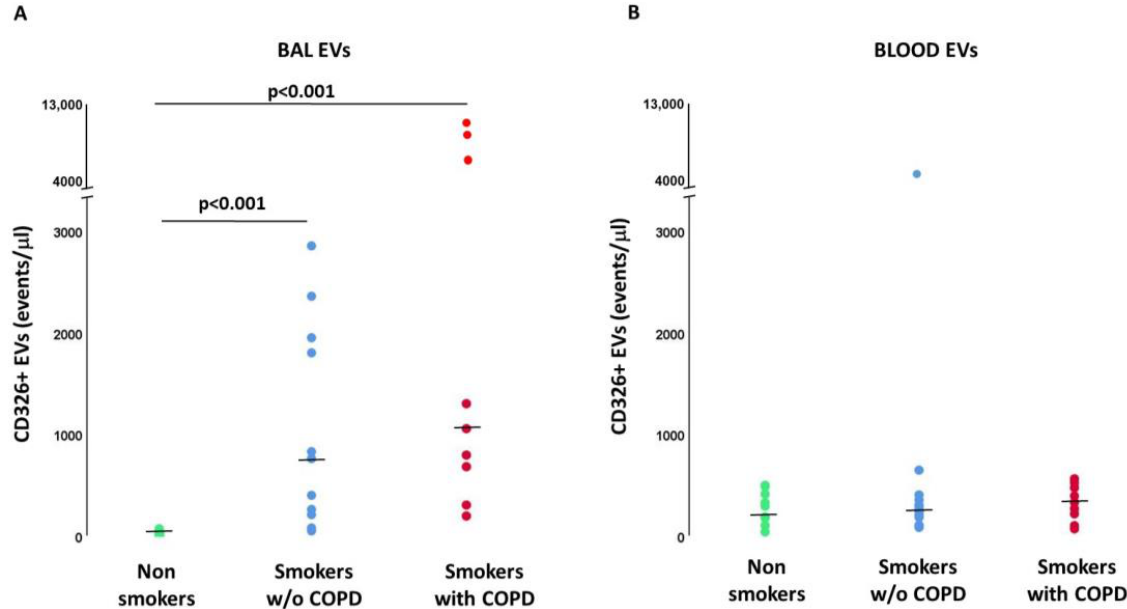
Figure 2. Epithelial-derived EVs (CD326+ events/μ L) in BAL ( A ) and Blood ( B ). p values in the figure represent the results of Mann-Whitney U tests. Kruskal-Wallis test: p < 0.001 for BAL EVs. Kruskal- Wallis test: p = NS for Blood EVs.